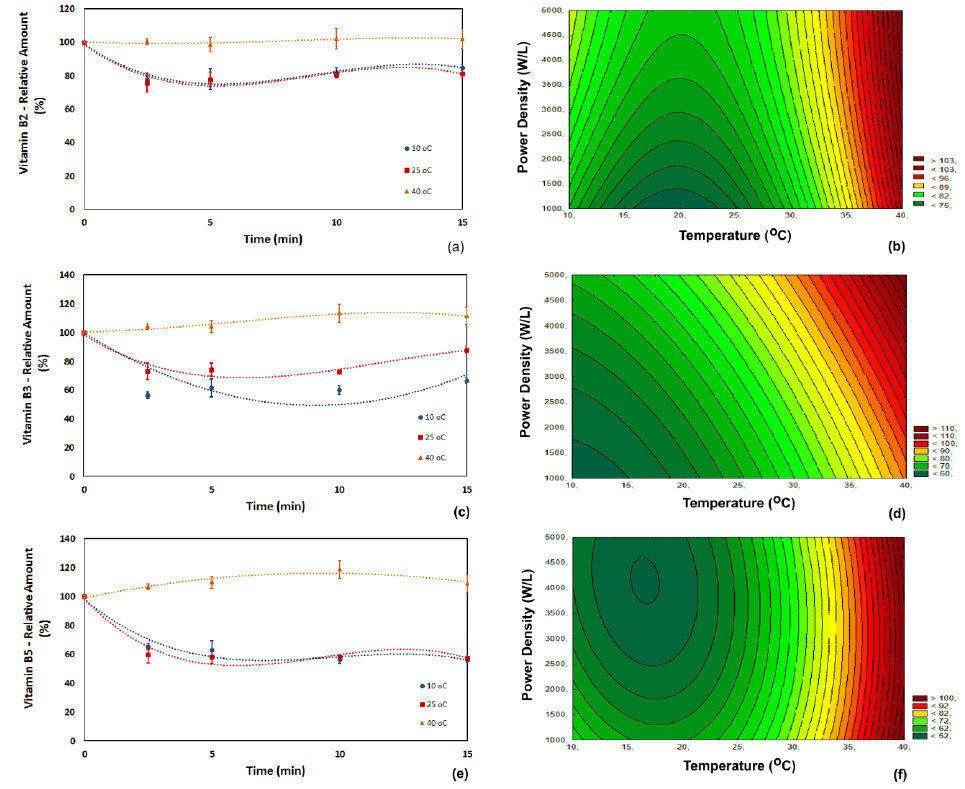
Figure 1. Influence of temperature, power density and processing time on the relative content of vitamins B in acerola juice. ( a , b ) Vitamin B 2 ; ( c , d ) vitamin B 3 ; ( e , f ) vitamin B 5 . The kinetics ( a , c , e ) was